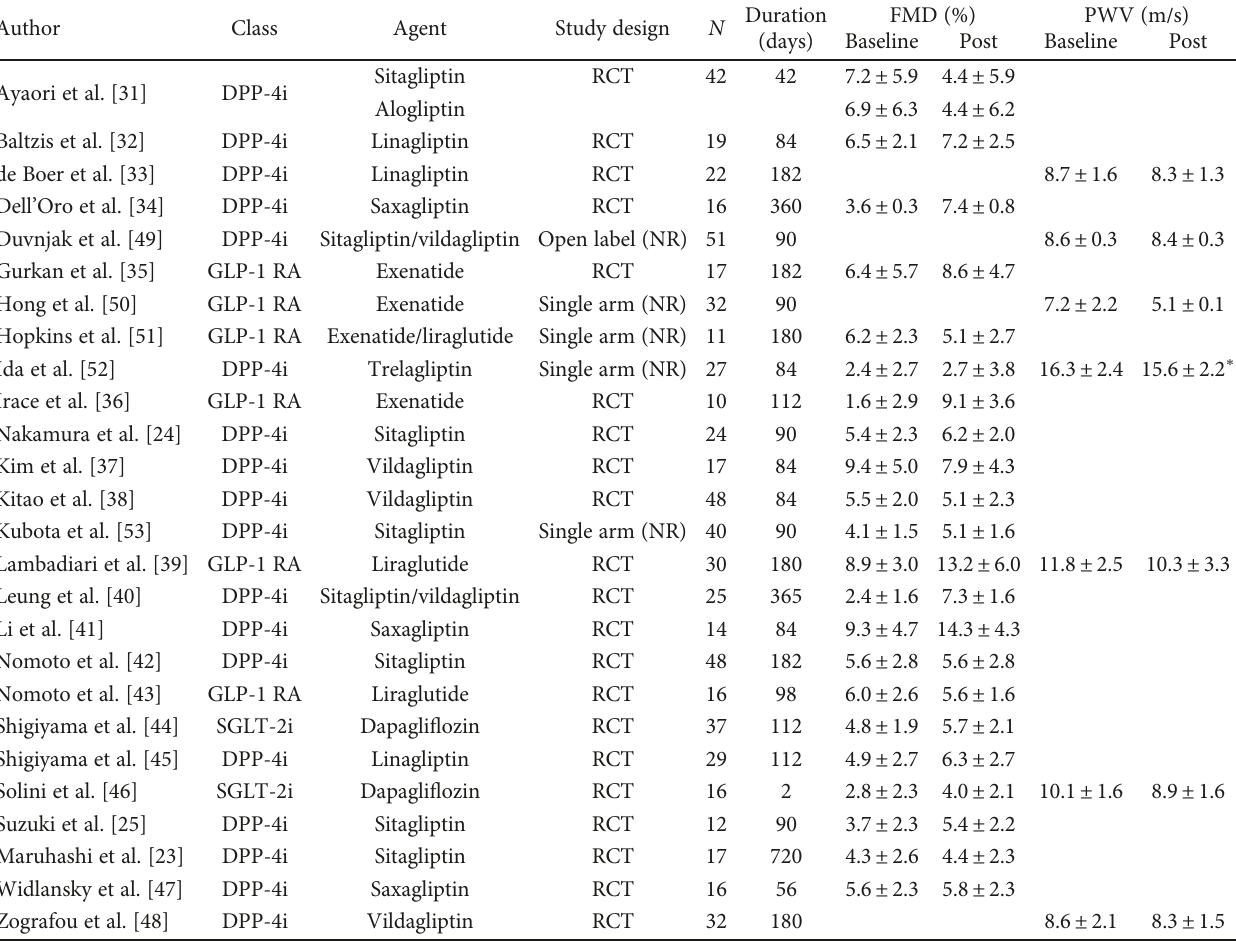
Table 1: Summary characteristics of studies included in the